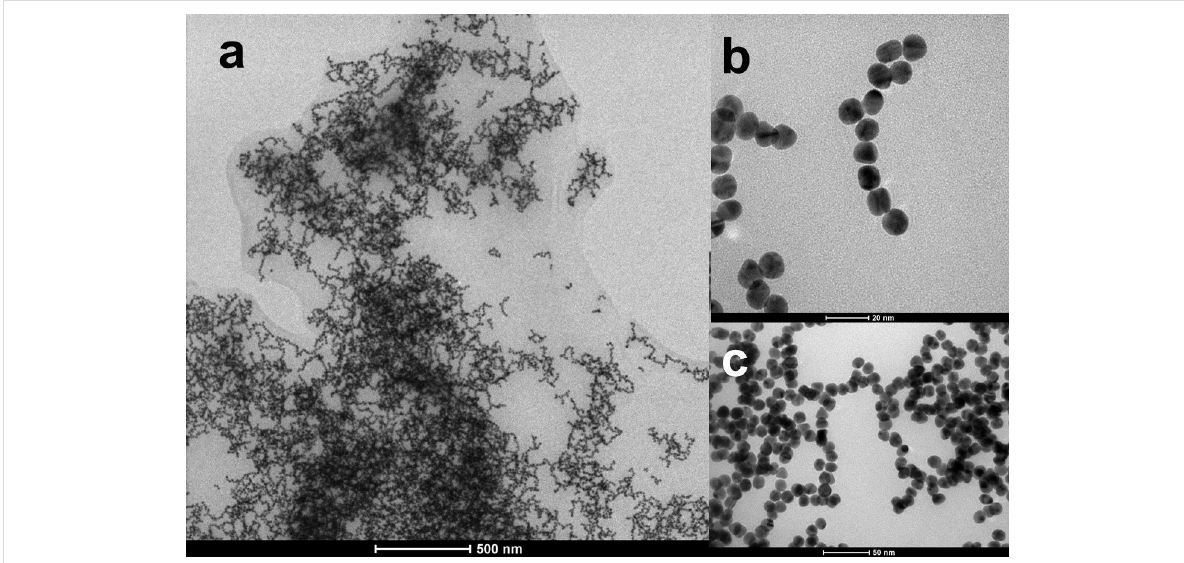
Figure 5: TEM micrographs of AuNP-SA-BiotinDNA after BiotinDNA displacement by free biotin (1.28 mM). TEM micrographs (a), (b), and (c) show aggregated nanoparticles with different magnification factors.